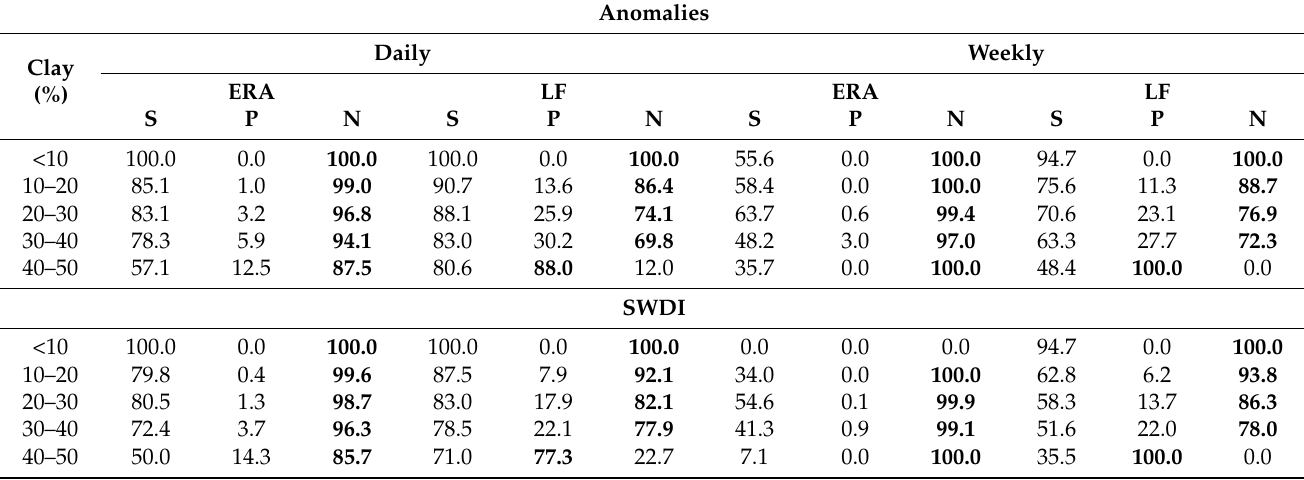
Table 6. Percentage of significant (S), positive (P), and negative (N) trends at daily and weekly scales and by the clay content interval. Maximum trend percentage values are in